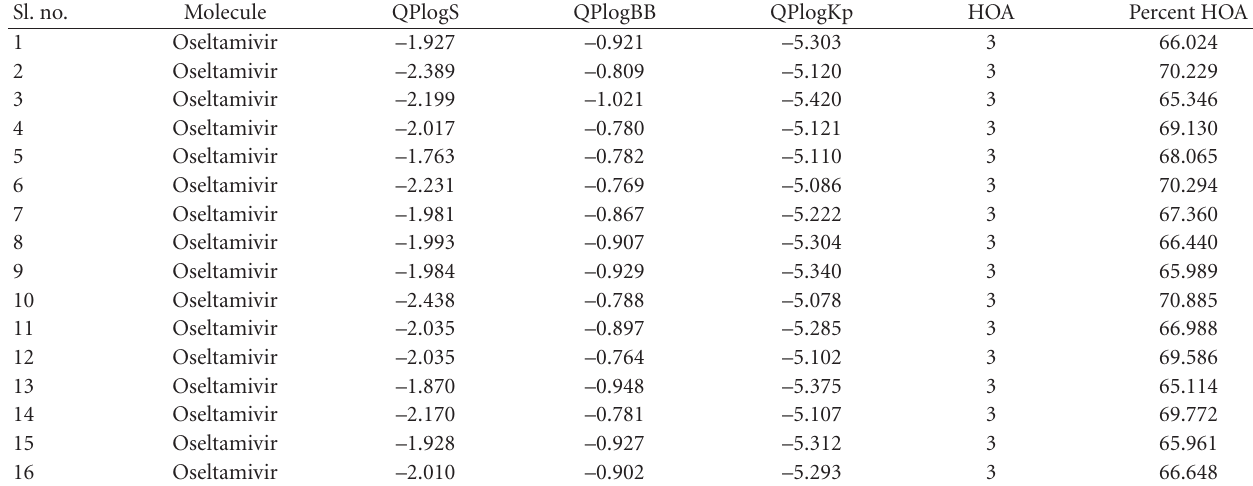
Table 4: Important ADME properties of Oseltamivir conformers as reported from Schrodinger. Sl.